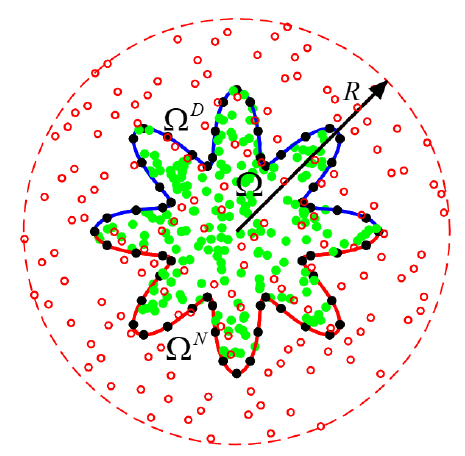
Figure 2. The node distribution with fictitious centre nodes (boundary nodes “ ● ” , interior nodes “ • ” and fictitious centre nodes “ ○ ” ).